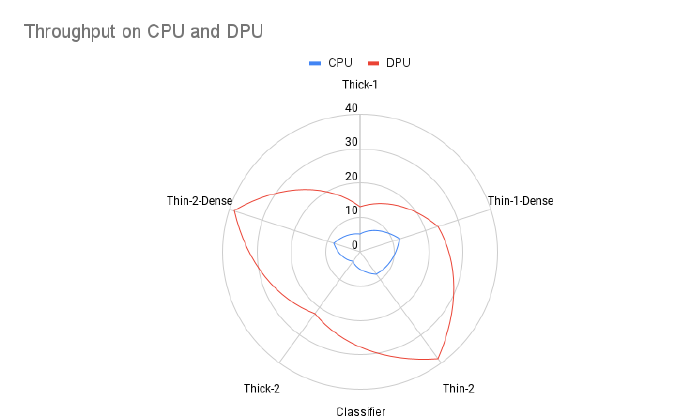
Figure 12. Gap between throughput on CPU and DPU.